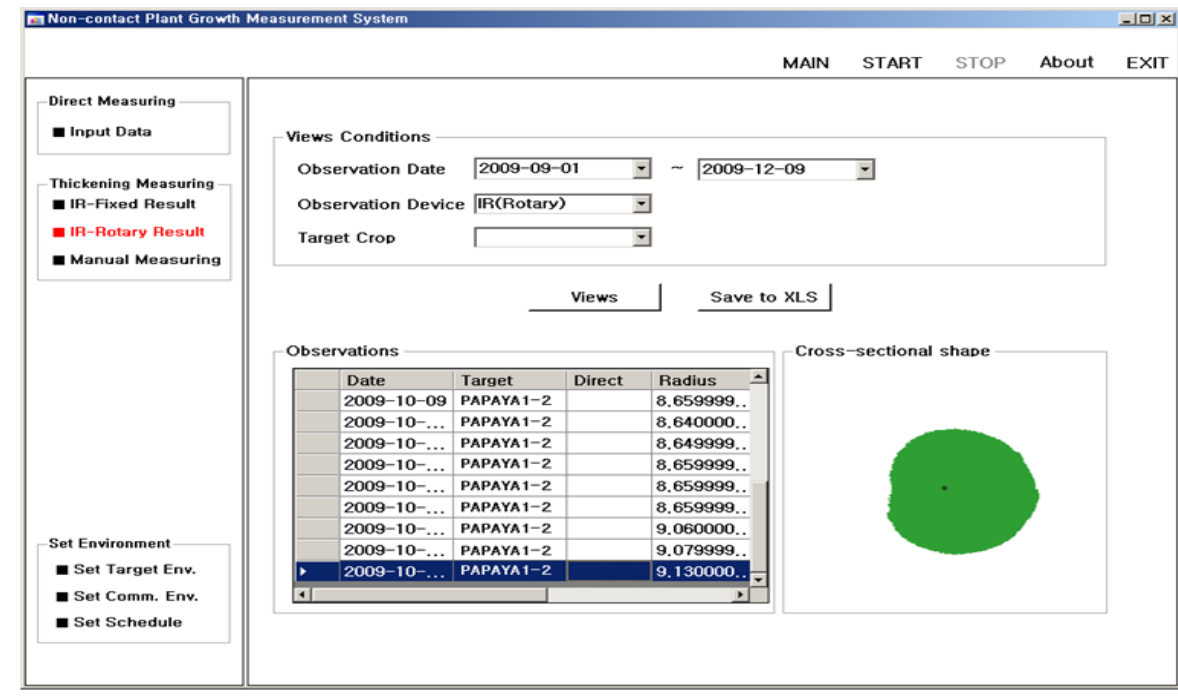
Figure 23. GUI of the Growth Measurement